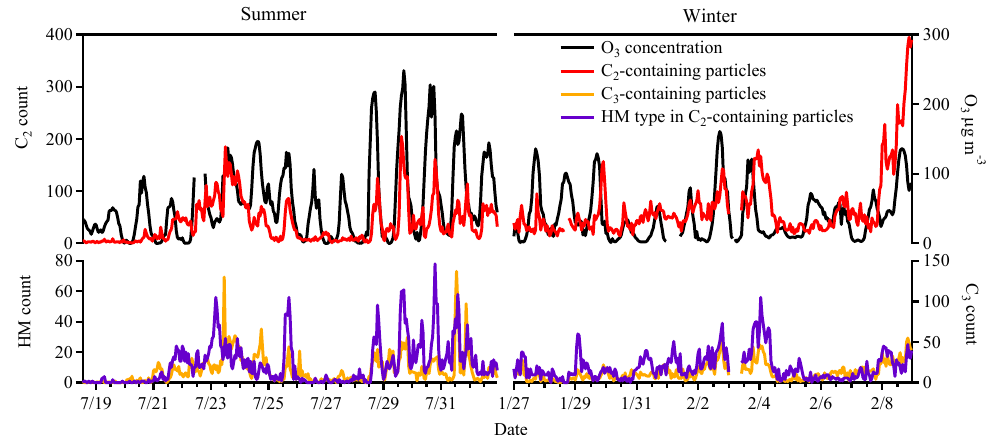
Figure 5. Temporal variations in O 3 concentrations, oxalic acid particles, malonic acid particles and heavy metal oxalic acid particles during the entire sampling period in Heshan,